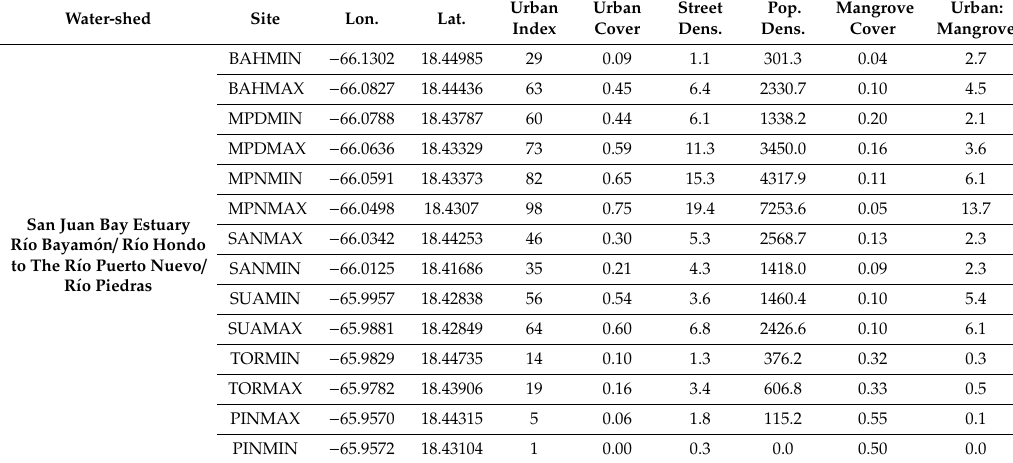
Table 1. Site abbreviations used throughout the study and their corresponding locations as well select urban variables from a 1000 m sampling radius, as adapted from Brano ff [44]. The urban index is a unitless metric of urbanness that incorporates several variables, with 100 being the most urban and 0 the least urban site relative to the others. Urban and mangrove cover are km 2 km − 2 , street density is km km − 2 , population density is people km − 2 , and the ratio of urban to mangrove cover (Urban:Mang) is